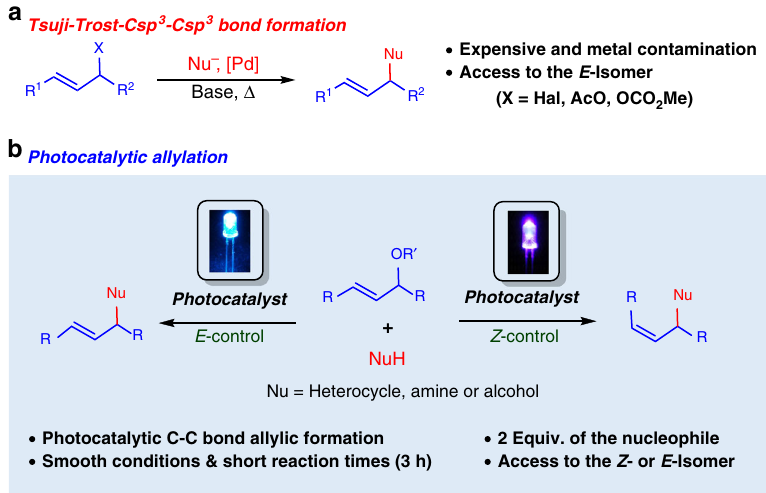
Fig. 1 The photocatalytic allylation reaction. a Precedents in the Tsuji – Trost allylation and b this